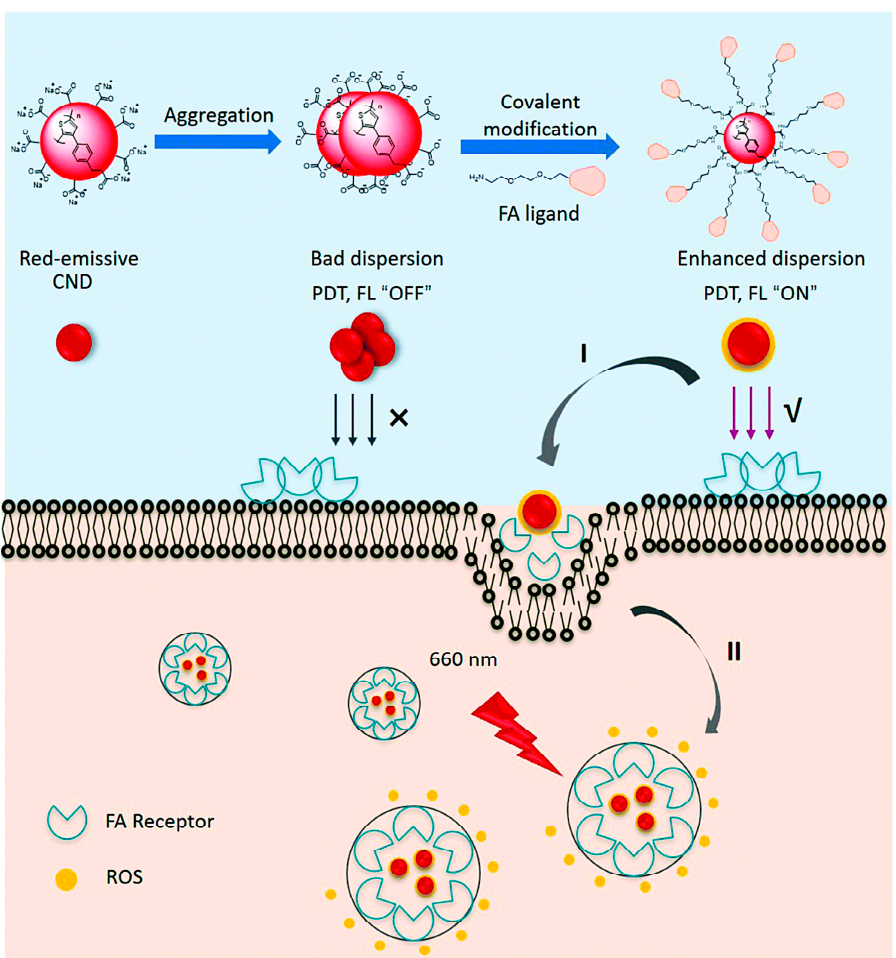
Figure 3. Schematic illustration of the covalent functionalization of RCNDs and their targeted intracellular production of ROS through ( I ) FR-mediated endocytosis and ( II ) light irradiation. FL stands for fluorescence, FA stands for folic acid [38]. Copyright 2020, Royal Society of Chemistry.